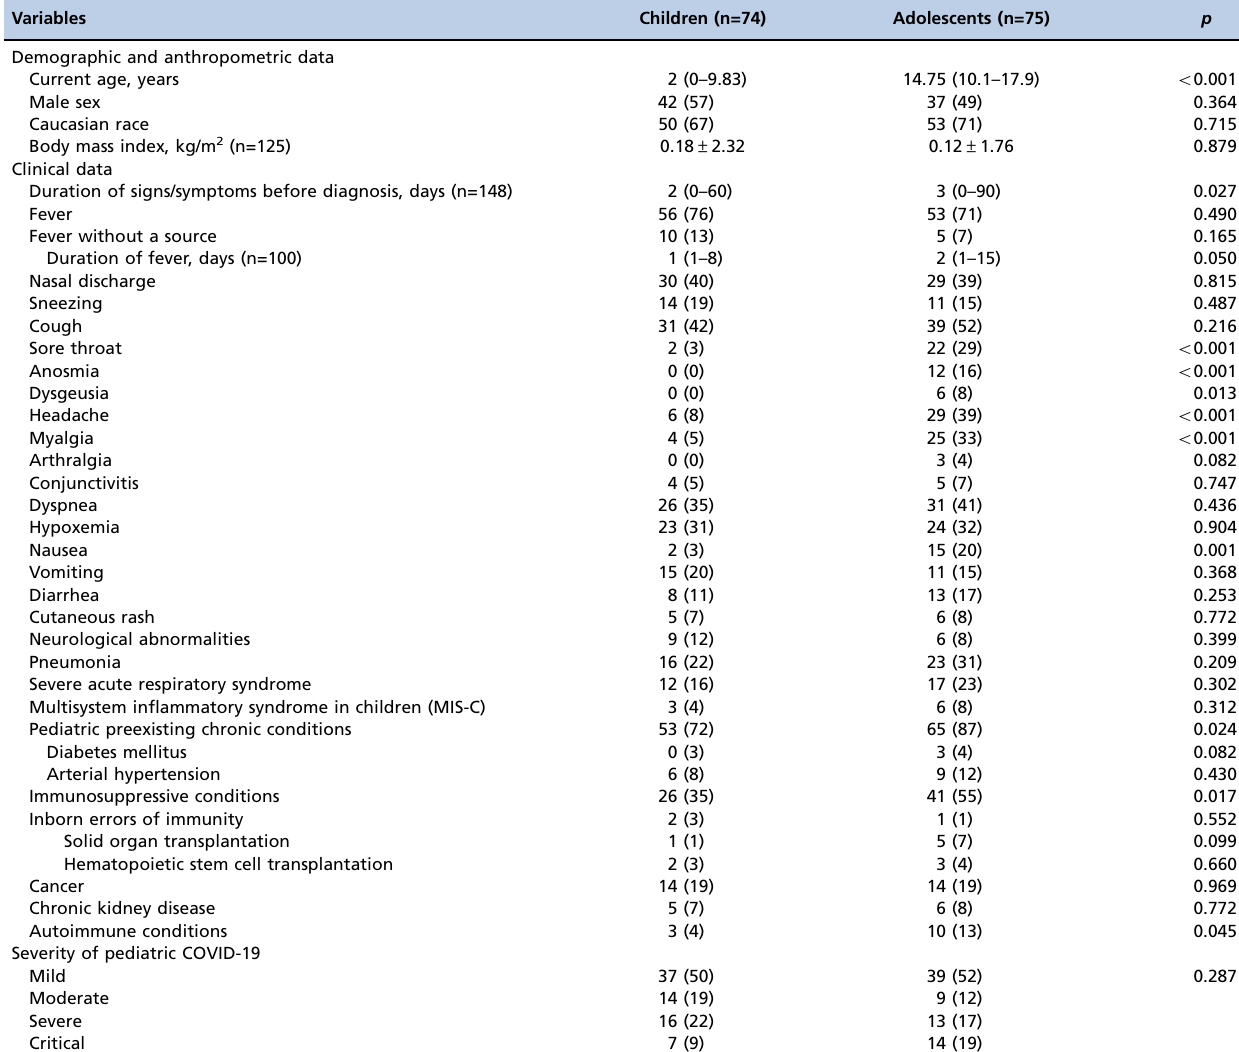
Table 1 - Demographic, anthropometric and clinical data and pediatric preexisting chronic conditions in children (aged o 10 years) vs. those in adolescents (aged X 10 years) with laboratory-confirmed coronavirus disease 2019 (COVID-19). Variables Demographic and anthropometric data Current age,